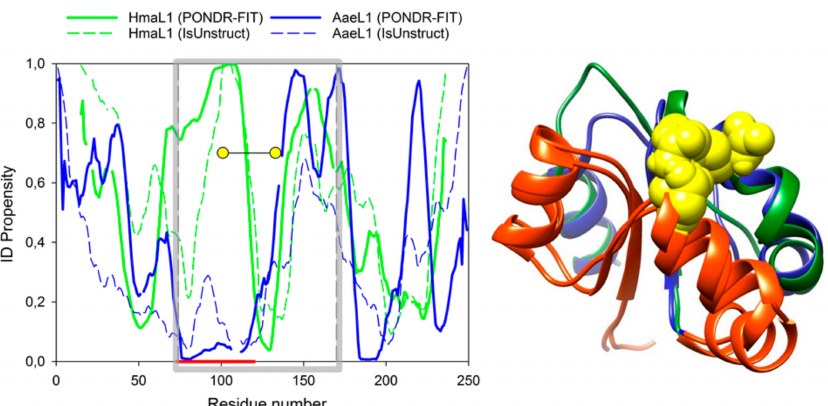
Figure 6. ( Left ) Calculation of intrinsic disorder propensities for amino acid sequences in HmaL1 (green) and AaeL1 (blue) proteins performed in PONDR ® FIT (solid lines) and IsUnstruct (dashed lines). Gray square limits regions of amino acid sequences forming domain II. Thick red line below the plot shows a region of the highest difference in intrinsic disorder propensities between AaeL1 and HmaL1 proteins. Yellow circles show the positions of inserted disulfide bonds. ( Right ) Superposition of three-dimensional structure of domains II of HmaL1 (green) and AaeL1 (blue). Regions of the highest difference in IDP part of AaeL1 and HmaL1 is colored red. Yellow spheres highlight amino acid residues selected for substitution to cysteine residues, D101 and K127 in AaeL1 and E82 and D114 in